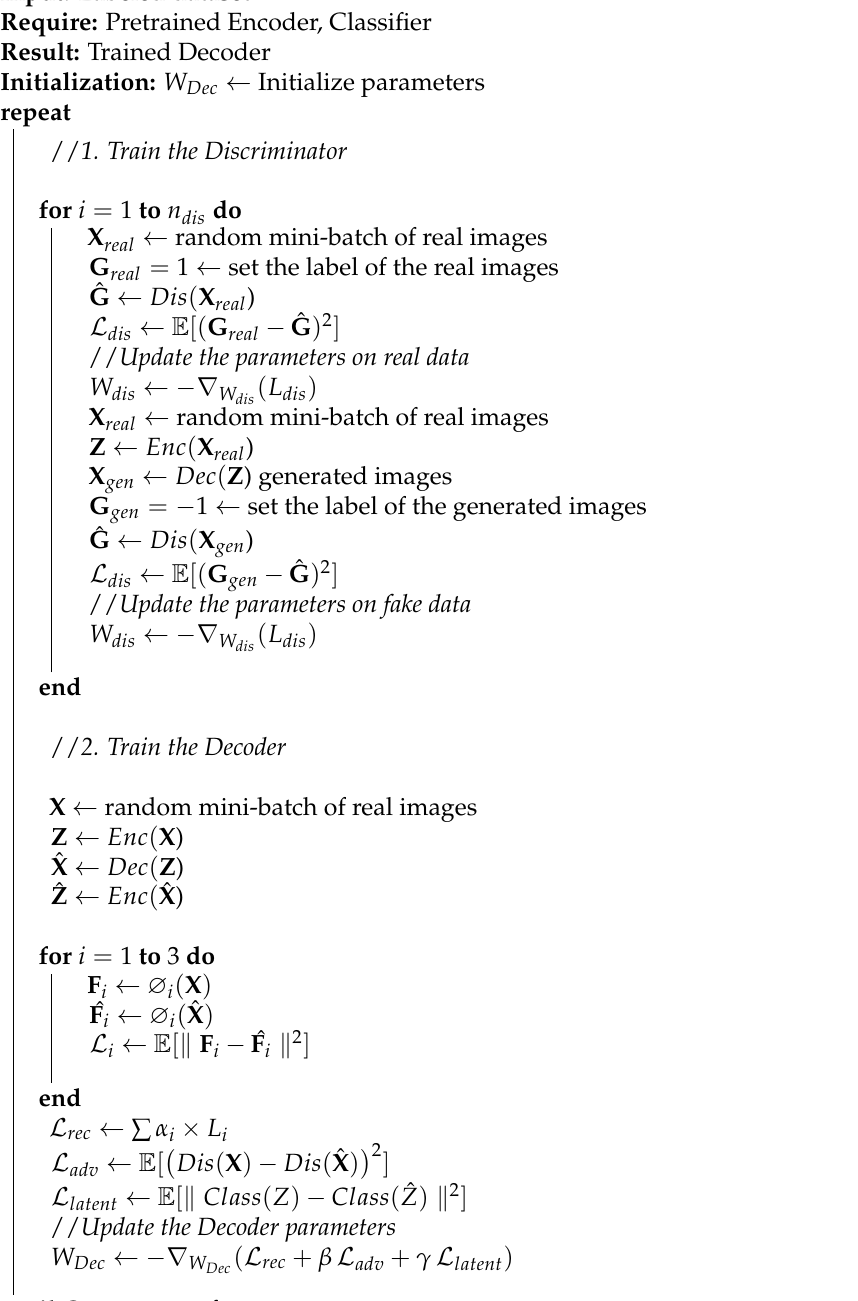
Algorithm 2 Training the Decoder